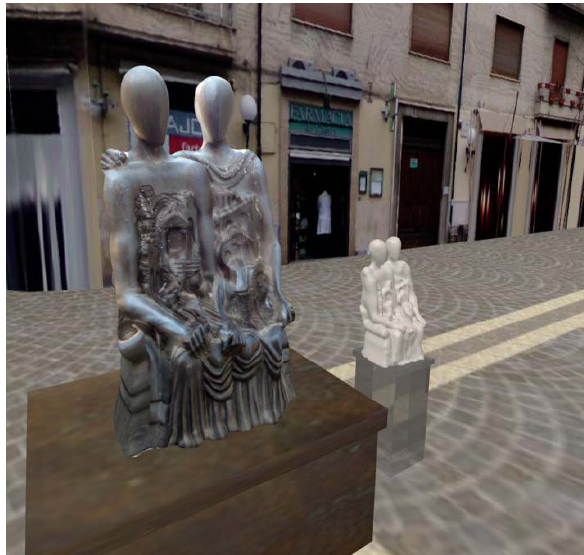
Figure 22. The models of The great archaeologists and of the miniature in the new position.